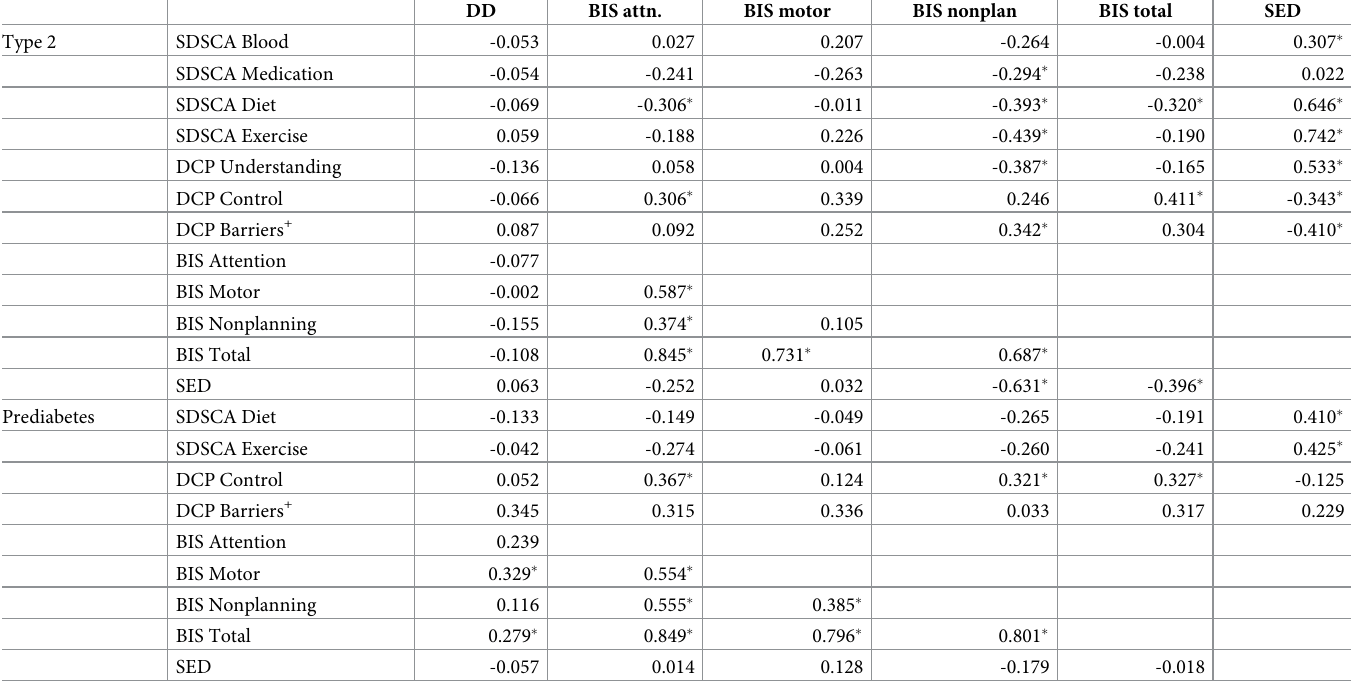
Table 3. Pearson zero-order correlations between impulsivity, self-efficacy, and self-care. DD BIS